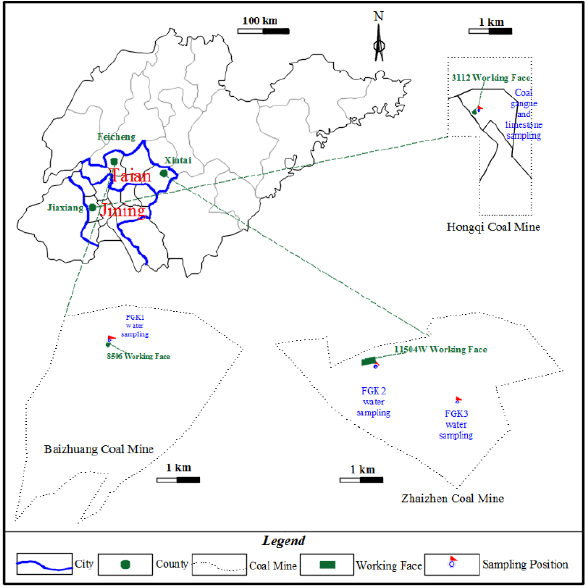
Figure 1. Location of the area.